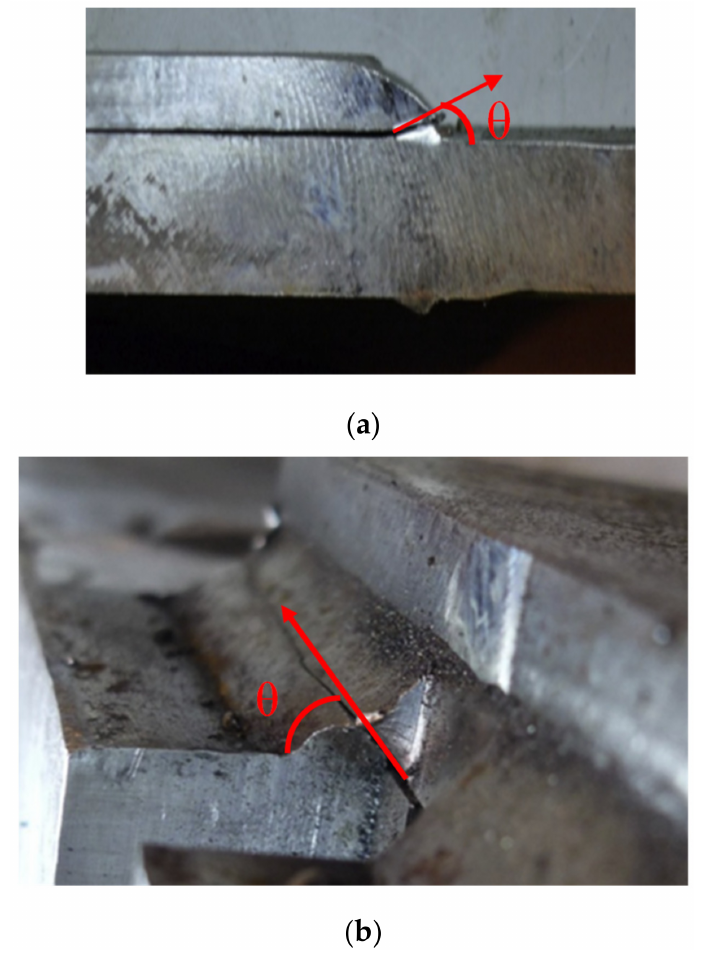
Figure 5. Failure angles for fillet welded lap joints (used with permission, Elsevier [3]). ( a ) Failure angle for transverse fillet welded joint; ( b ) Failure angle for longitudinal fillet welded